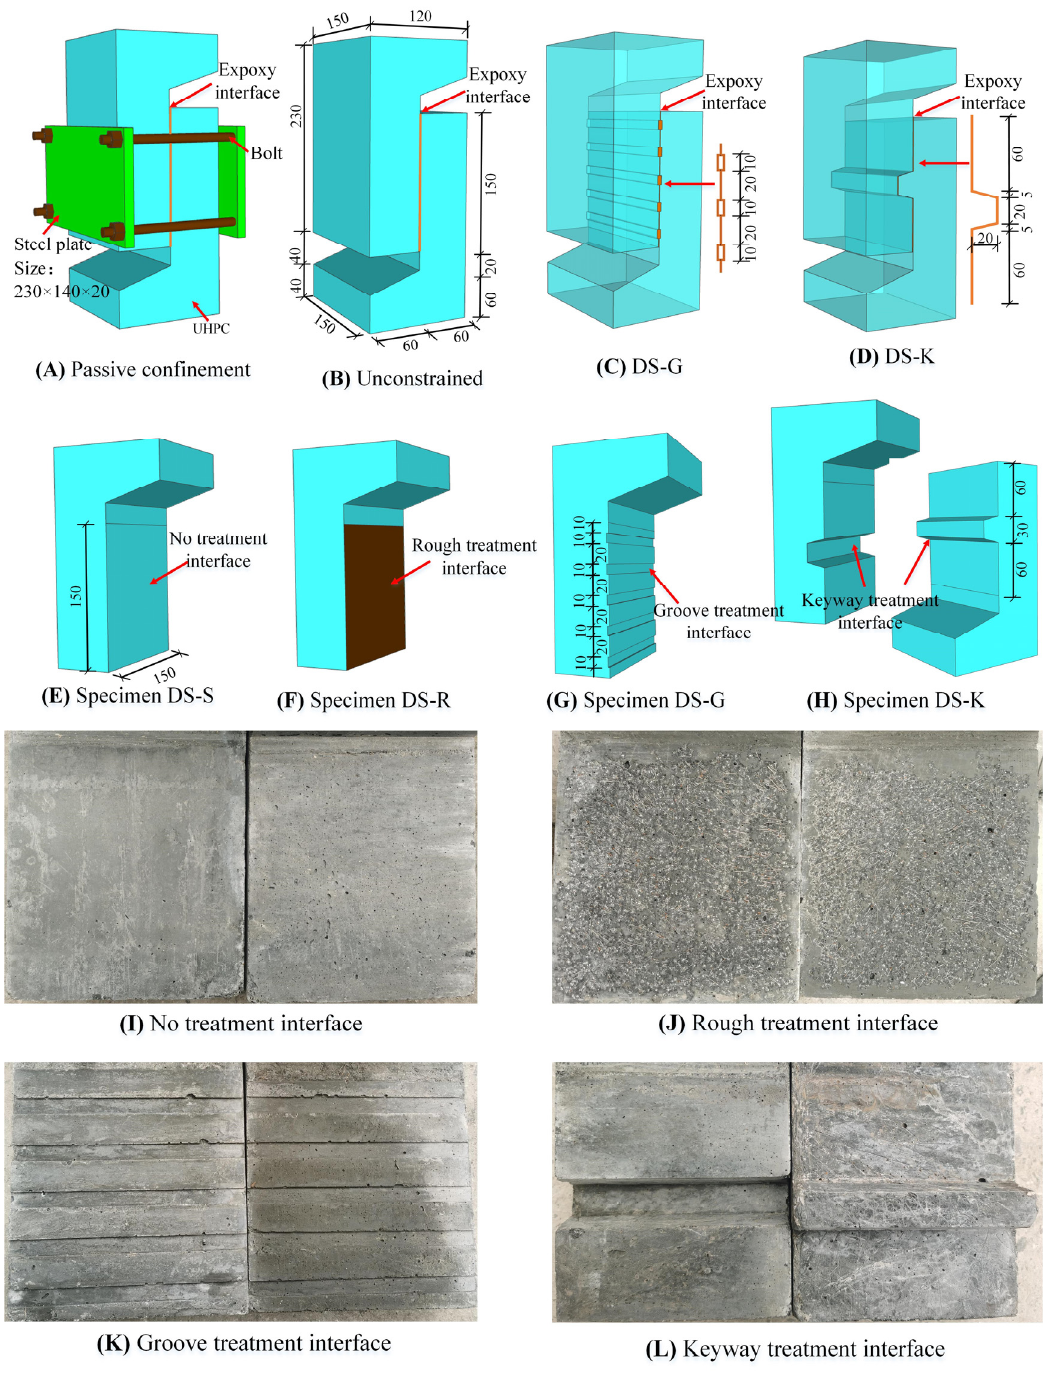
Figure 1. Details of the specimen: ( A , B ) schematic diagrams of passive restraint and unrestrained loading; ( C , G ) components and overall structure of the specimens DS-G and PC-DS-G; ( D , H ) the components and overall design of the test pieces DS-K and PC-DS-K; ( E , F ) parts of specimens DS-S, DS-R, PC-DS-S, and PC-DS-R; ( I , J , K , L ) the specimens after smooth, rough, groove, and key groove interface treatment, respectively. Unit: mm.